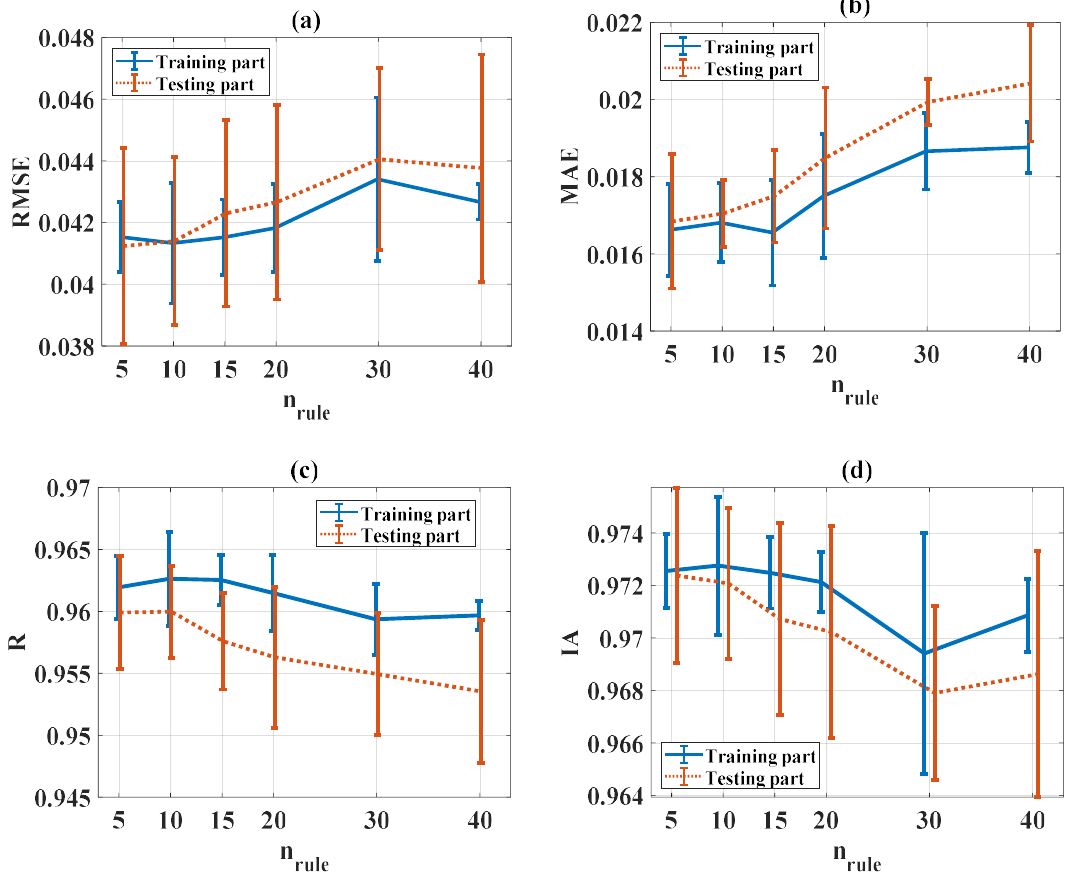
Figure 8. Evaluation of statistical criteria in the function of n rule : ( a ) RMSE, ( b ) MAE, ( c ) R, and ( d ) IA.